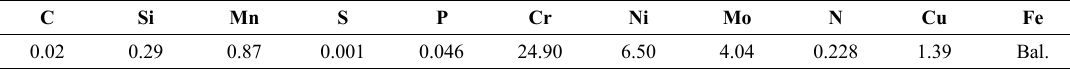
Table 1. Nominal chemical composition (in wt %) of the SDSS UNS